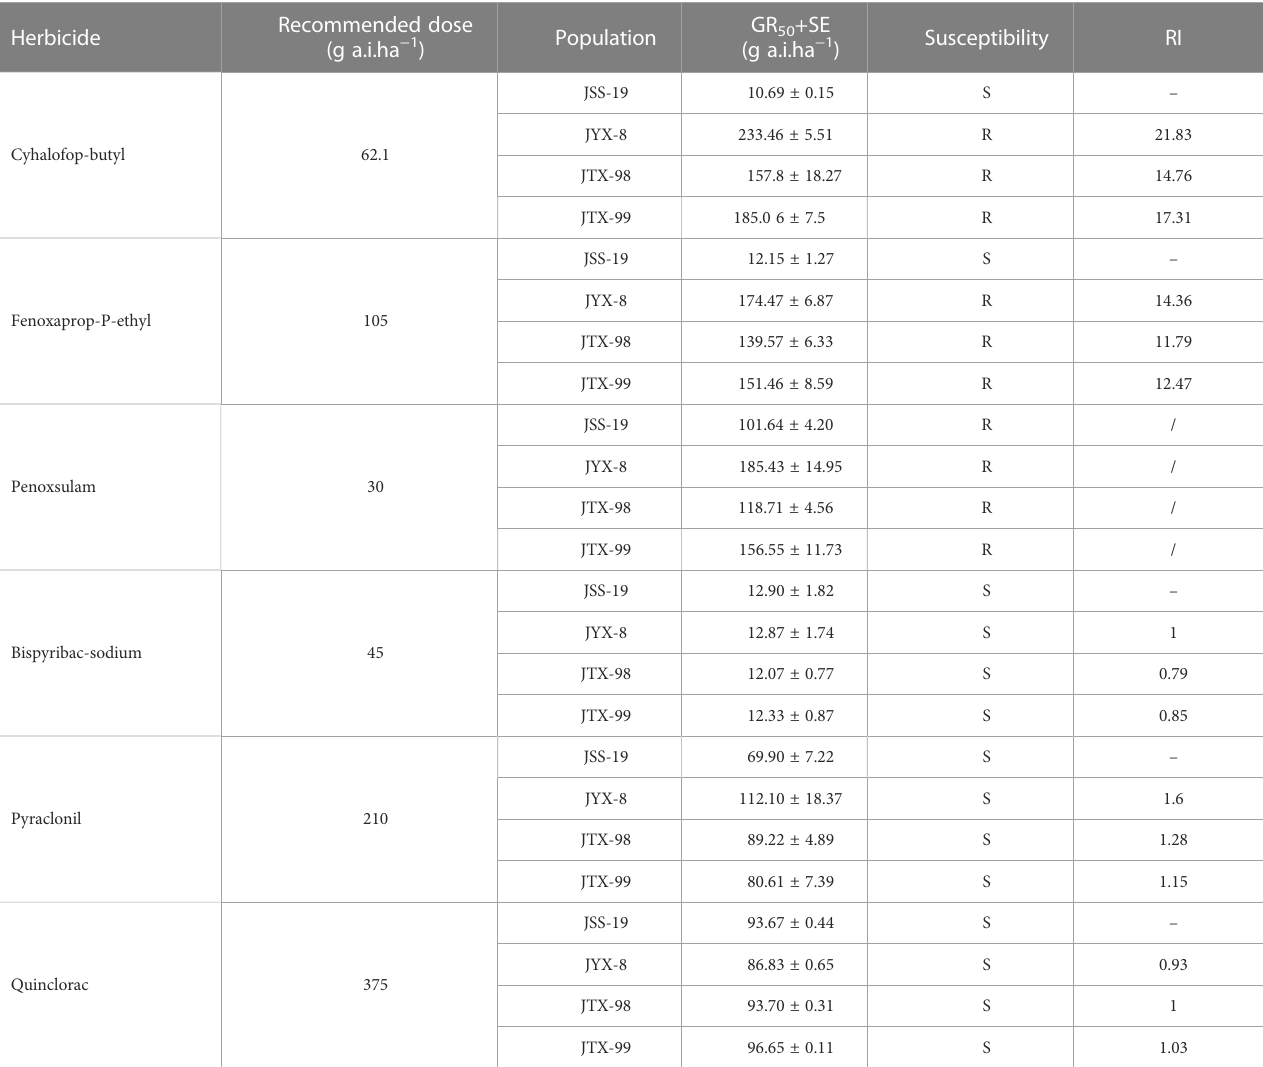
TABLE 7 Sensitivity of D . ciliaris var. chrysoblephara to other herbicides.